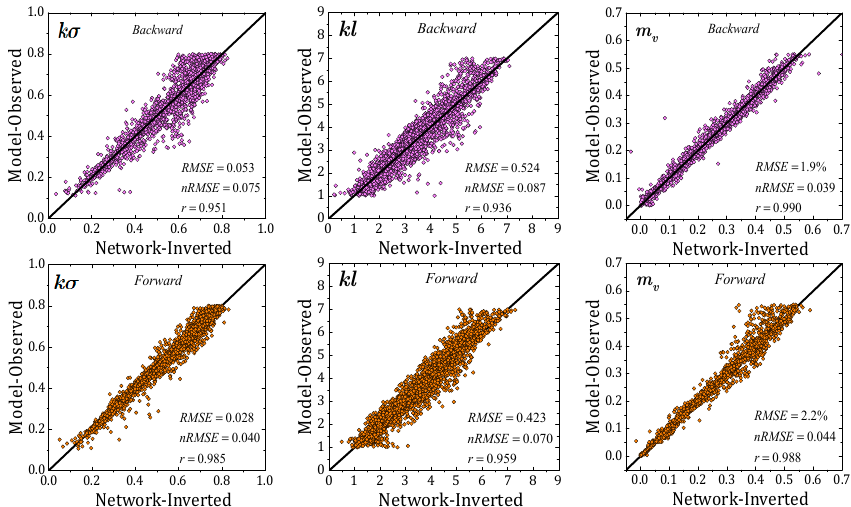
Figure 12. Retrieval performance of surface roughness and soil moisture from bistatic scattering data (three-input). Top row: backward region. Bottom row: forward region.